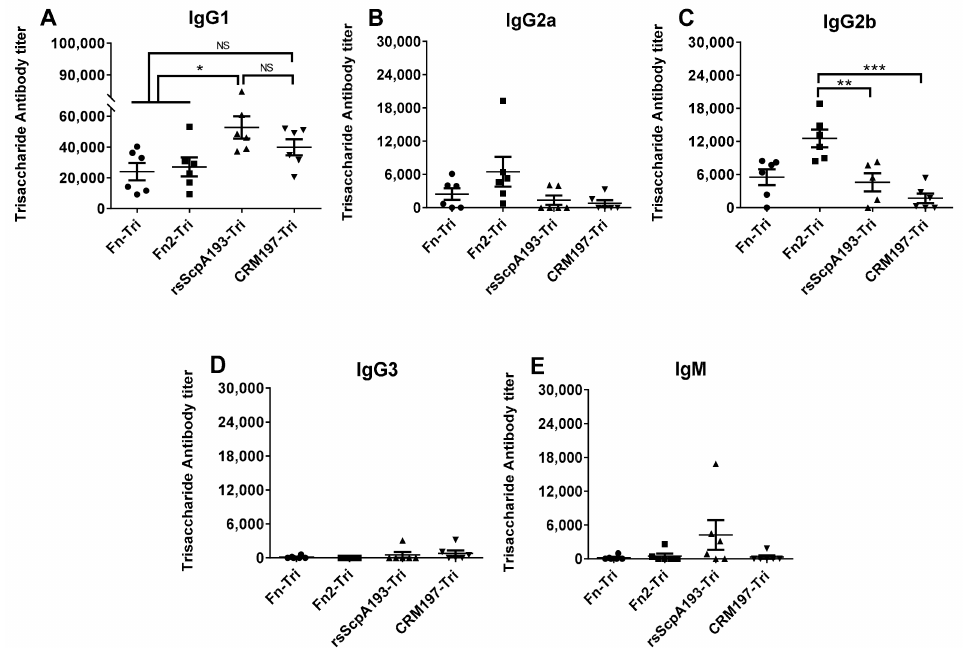
Figure 8. ELISA results showing the ( A ) IgG1, ( B ) IgG2a, ( C ) IgG2b, ( D ) IgG3 and ( E ) IgM antibody titers in the day 35 antisera of mice immunized with Fn-Tri ( • ), Fn2-Tri ( (cid:4) ), rsScpA193-Tri ( (cid:78) ), and CRM197-Tri ( (cid:72) ), respectively, using BSA-Tri as the capture antigen. Each dot represents the result of an individual mouse, and the black bars show the mean ± SEM values. NS: Not statistically significant; *: significantly different ( p < 0.05) **: very significantly different ( p < 0.01); ***: extremely significantly different ( p <